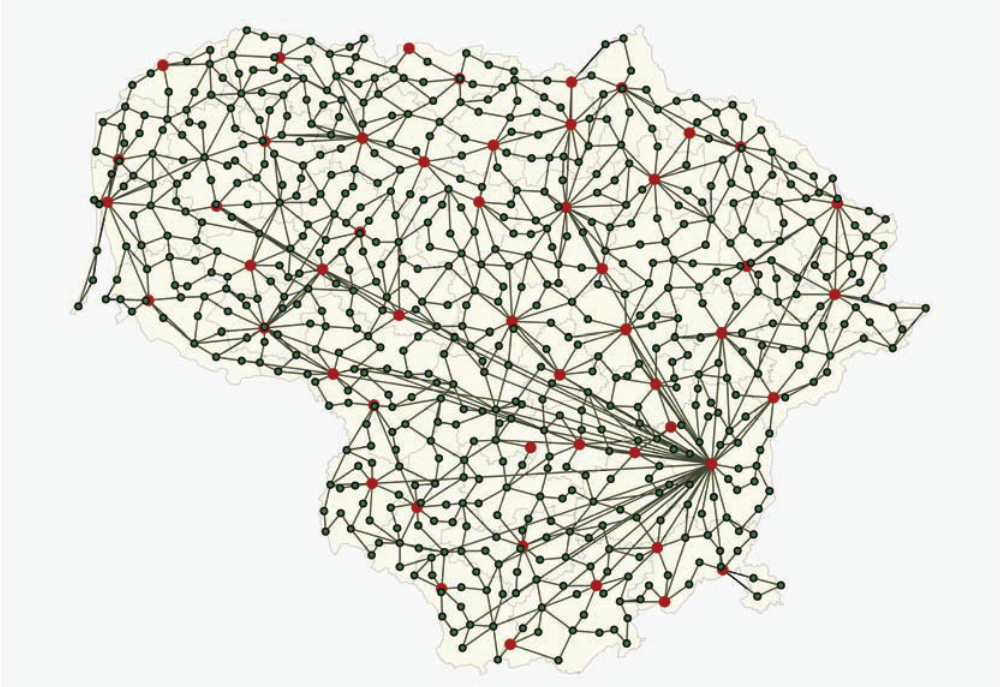
Fig. 1 . The scheme of placing gravimetric points (red - zero and first order points, green - second order points, lines mark differences in the measured gravity